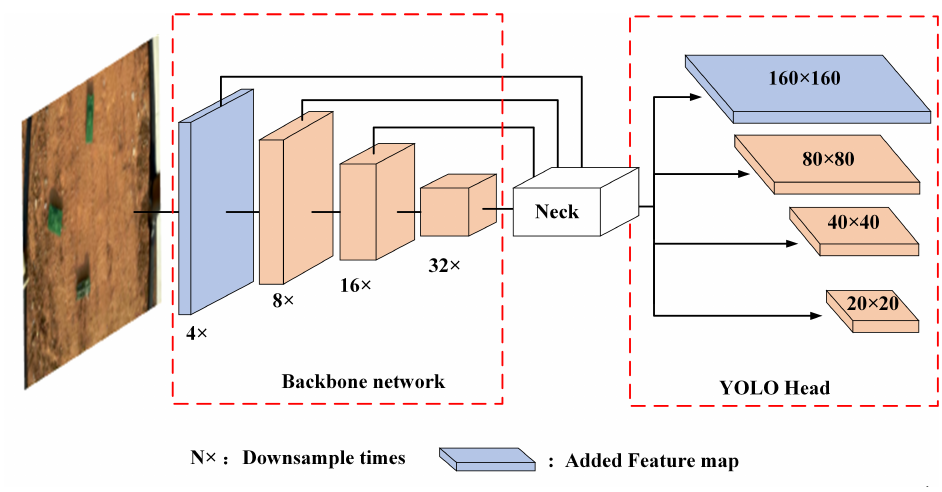
Figure 7. The model of feature